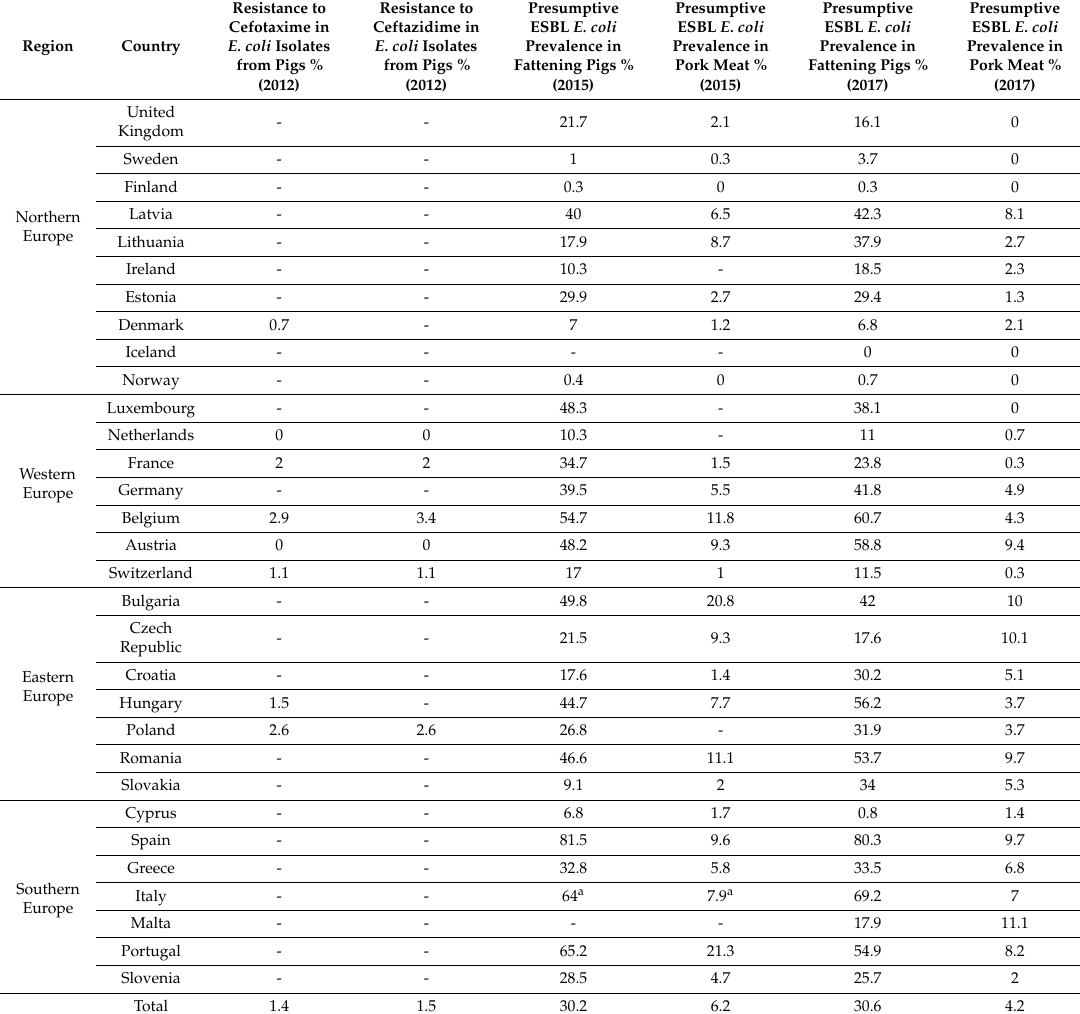
Table 3. Prevalence of ESBL-producing, cefotaxime- and ceftazidime-resistant, E. coli isolates from fattening pigs and pork meat in the EU, 2012–2017. Adapted from [18,19,96].